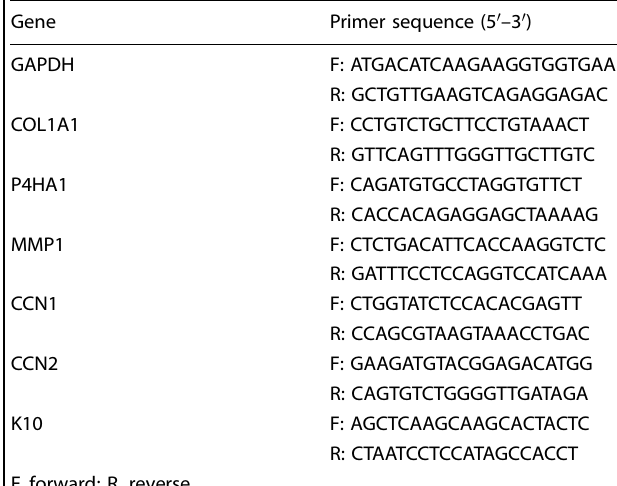
Table 1. Primer list for quantitative real-time